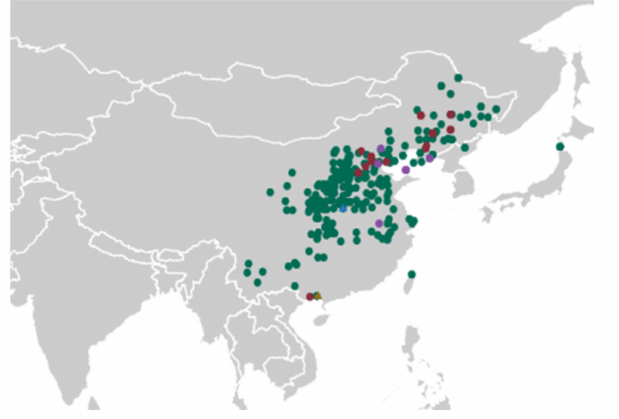
Figure 6. Geographical distribution of the accessions used in the study ( n = 475). Dots with different color represents landraces (green), cultivated varieties (red) and wild (purple). Blue triangles represent the Nanyang city test sites, and brown triangles represent Nanning city test